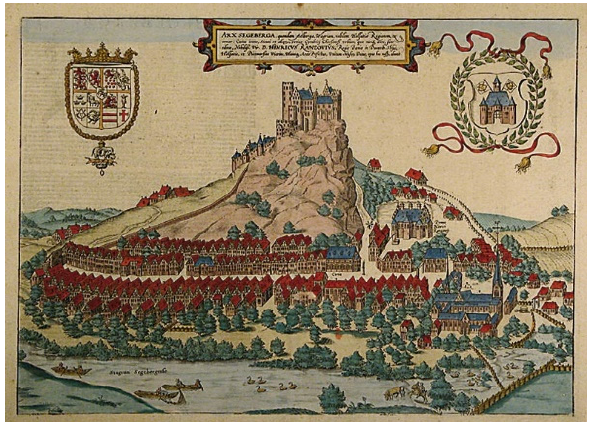
Figure 1. Historic engraving of the two towns Segeberg and Gieschenhagen in the year 1588 from Braun-Hogenberg